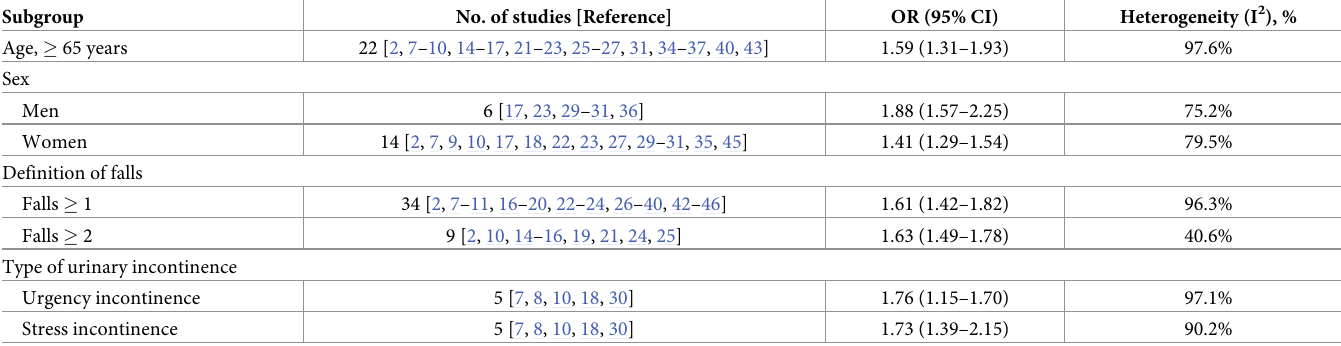
Table 2. Subgroup analysis of the association between urinary incontinence and falls.